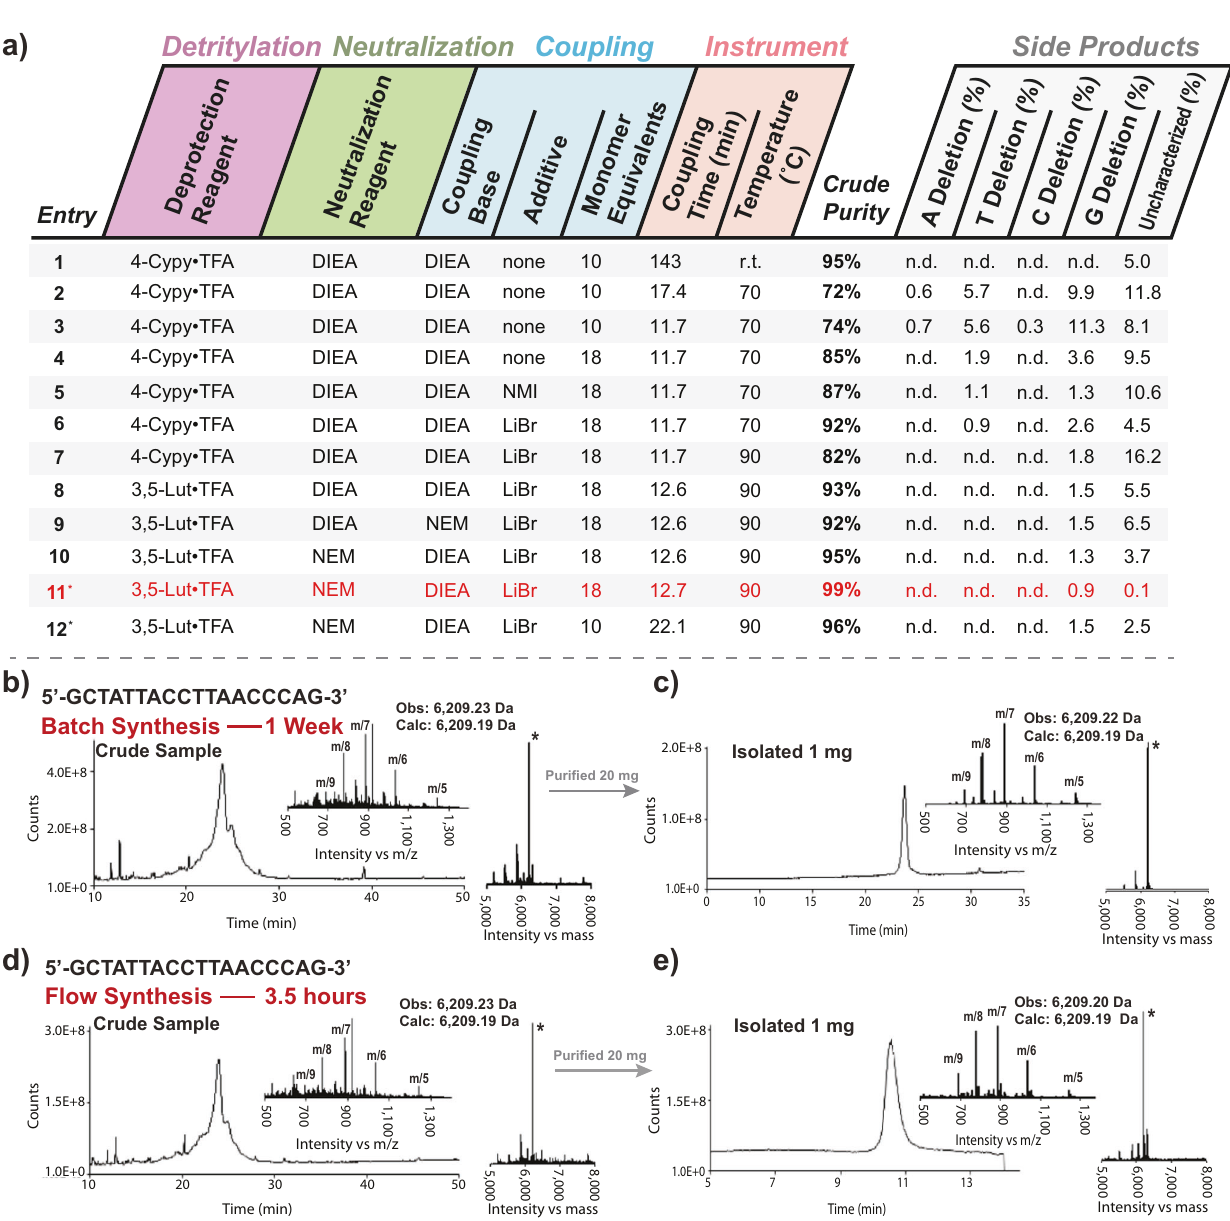
Fig. 4 Optimized fl ow synthesis produces PMOs with similar purity to manual batch protocols. a Synthesis variables were changed in sequence, and relative crude purities were tracked by comparison of the crude LC – MS traces. Crude purity and deletion sequences quanti fi ed, as described in Supplementary Section 6. *The Python script was edited to slowly deliver the monomers, reducing fl ow inaccuracies due to the viscous solution of the G monomer. N.d. = levels were below the sensitivity of detection with the described quanti fi cation method — not detected. Column colors indicate which category the variables correspond to pink — detritylation, green — neutralization, blue — coupling, and orange — instrument. Red lettering in-line 11 denotes the best observed conditions. b The total ion current chromatogram (TICC) of a batch-synthesized sample of the 18-mer PMO IVS2-654 is shown along with the mass spectrum and associated deconvoluted mass spectrum. c The TICC of the batch-synthesized sample after puri fi cation by cation exchange chromatography is shown along with the mass spectrum and associated deconvoluted mass spectrum. d The TICC, mass spectrum and deconvoluted mass spectrum are shown for the crude product from a fl ow synthesis of the same 18-mer sequence. e The TICC of the fl ow-synthesized sample after puri fi cation along with the mass spectrum and deconvoluted mass spectrum. Note: traces c and e were acquired using different LC – MS